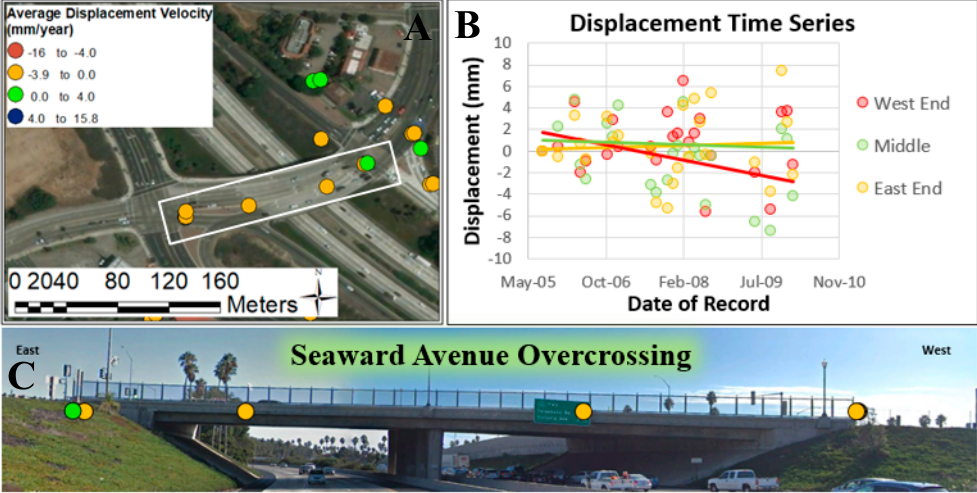
Figure 9. Seaward Avenue overcrossing displacement model. ( A ) Aerial view of the bridge; ( B ) Displacement time series; ( C ) Elevation view of the bridge. Source: Images for Figure 9A,C were obtained from Google Earth [48].